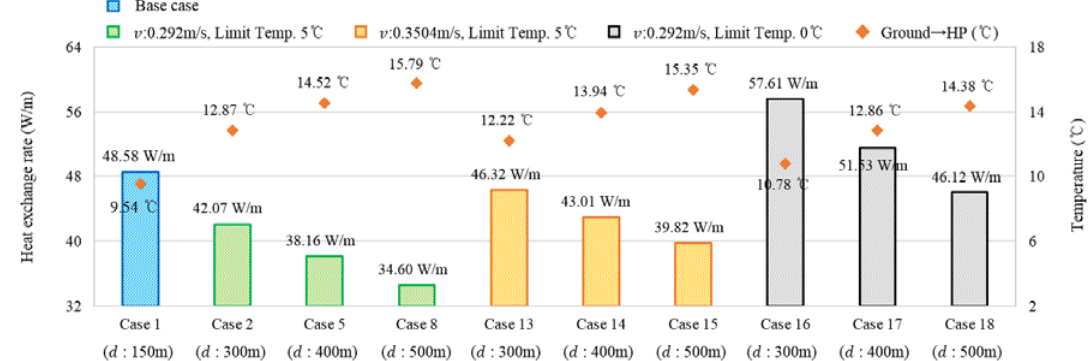
Figure 11. EWT and HER according to the operation method and the length of the GHX.